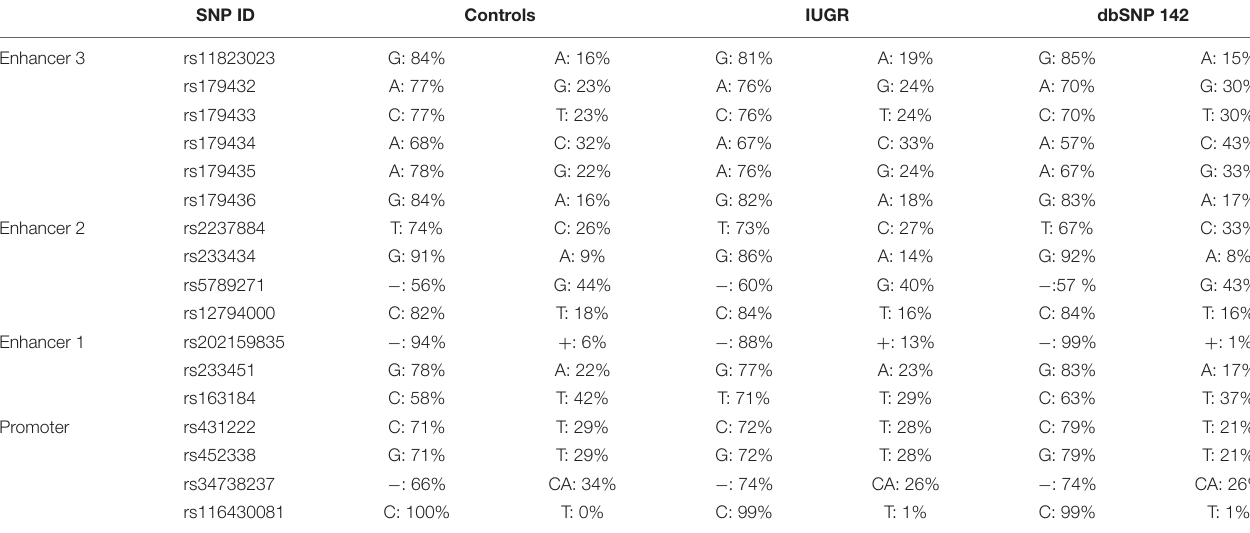
TABLE 4 | SNP reference numbers, genetic variants, and population frequencies listed according to NCBI dbSNP database. SNP ID Controls IUGR dbSNP 142 Enhancer 3